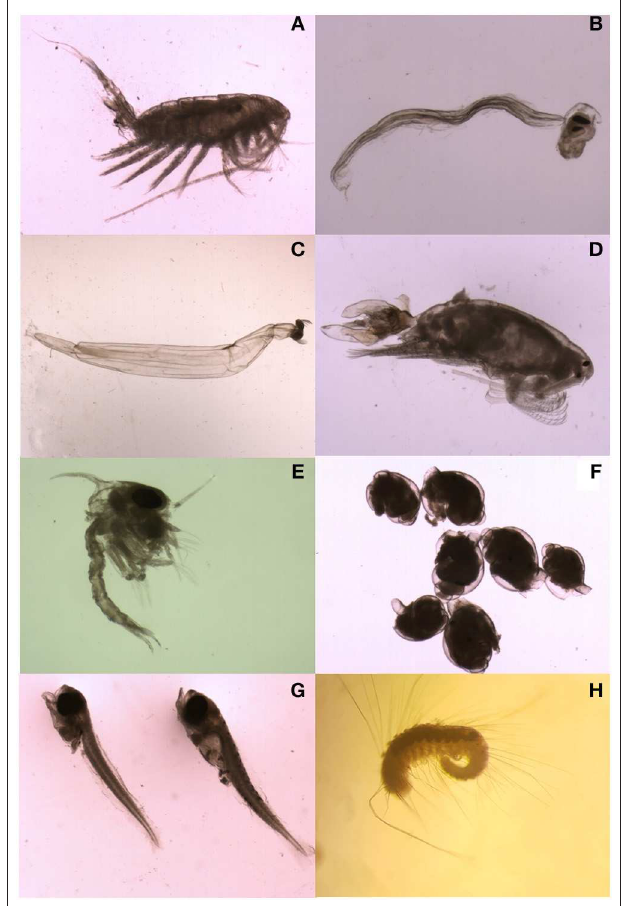
FIGURE 5 | Images of zooplankton of interest to this study, holoplankton (A) Calanoid Copepod < 2mm (Centropages spp. 1.55mm length) (B) Appendicularian (2.07mm) (C) Chaetognath (6.88mm) (D) Calanoid copepods > 2mm (Labidocera stylifera, 2.88mm) and meroplankton (E) Decapod larvae ( ∼ 2mm) (F) Gastropod larvae ( ∼ 1mm) (G) Fish larvae ( ∼ 4mm), (H) Polychaete larvae ( ∼ 3.5mm). (A–G) were taken with an Infinity camera mounted to a Zeiss Discovery. V8.